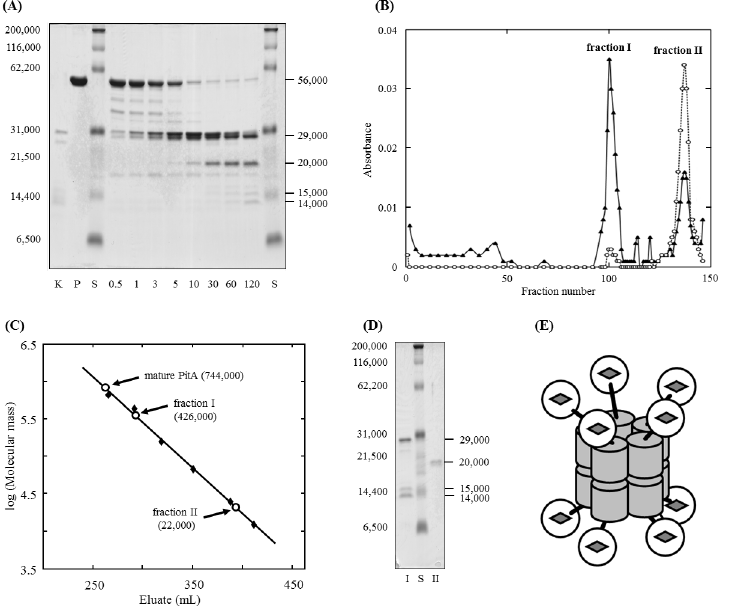
Fig 3. Molecular characterization of PitA by limited proteolytic analysis. SDS-PAGE of the proteinase K- digestedfragmentsof PitA is shownin ( A ).Numbersbelowthe lanesindicateeachreactiontimes(min) after the start of proteolysis.In lanesP andK, the purifiedPitA andproteinaseK usedin the experiment, respectively, wereloaded.The M r standardwasloadedin laneS. Estimated M r s of the fragments areindicatedon the right sideof the gel,whilethoseof the standardproteinsare on the left side.In ( B ),the proteolytic digestobtainedafter the 120minreactionwasfractionated by gelfiltration.Proteinsandhememoietiescollectedin eachfractions weremonitored by measuring the absorbance at 280nm (closedtriangles)andat 410nm (opencircles), respectively. Apparent M r s of the two fractions,I andII, that wereelutedat aroundthe 100 th and147 th tubes, respectively, wereestimatedas shownin ( C )usingthe M r standardproteinsas described in the Methods. Estimationof the M r of PitA in the maturestate wasperformedsimilarly.Resultsof the SDS-PAGE of the fractionsI andII are indicated in ( D ).N-terminalaminoacidsequencesof eachfragmentsweredeterminedas described in the ResultsandDiscussion. A possiblestructuralmodelof the PitA estimatedfrom theseresultsis represented in ( E ).